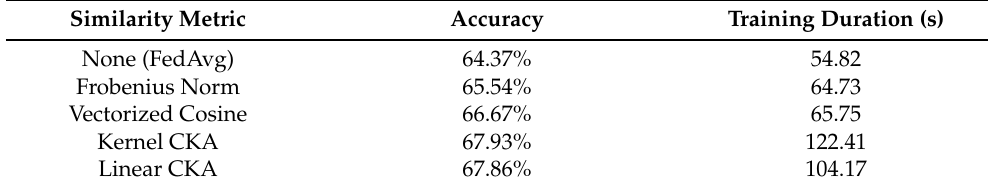
Table 3. Accuracy and training duration with FedCKA with different similarity metrics (CIFAR-10).